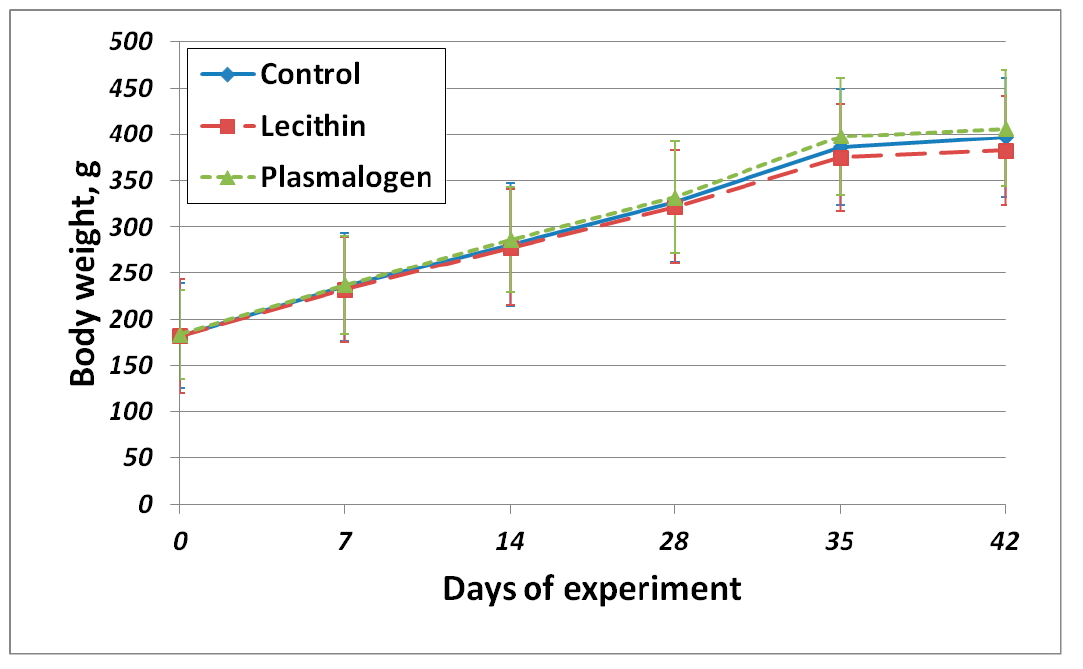
Figure 2. Average body weight gain. Values are mean ± SEM of 15 rats per group.